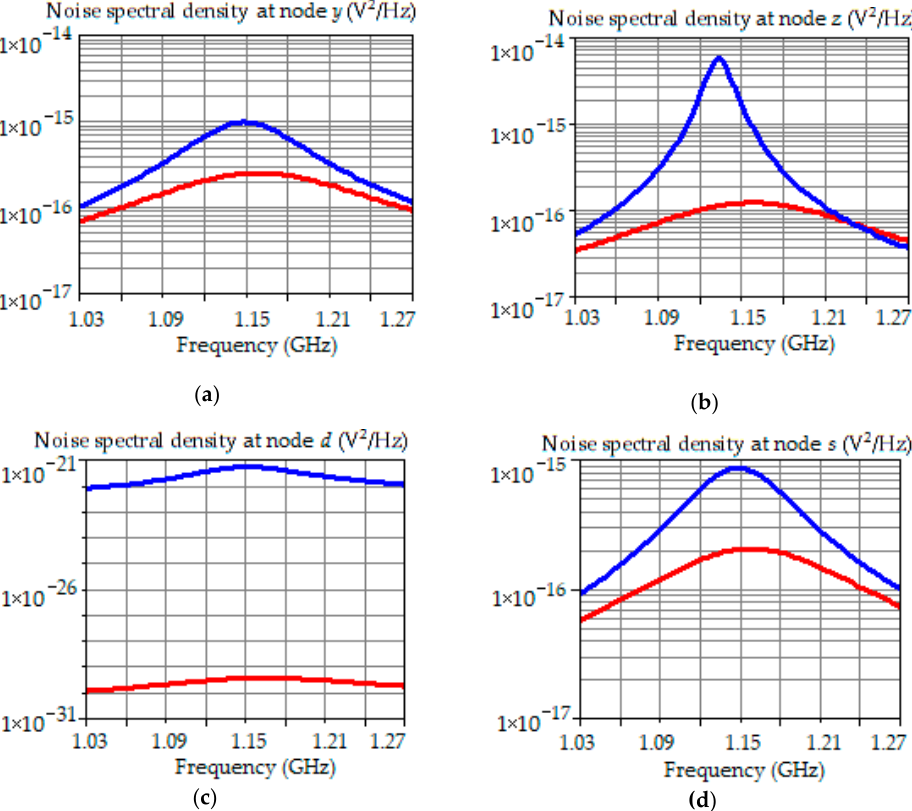
Figure 7. Noise spectral density at nodes y (a) , z (b) , d (c) , and s (d) when 𝐶 (cid:2868) = 1 nF and 𝐶 (cid:3007) = 5 pF (blue line) and 𝐶 (cid:2868) = 10 μF and 𝐶 (cid:3007) = 10 pF (red line).